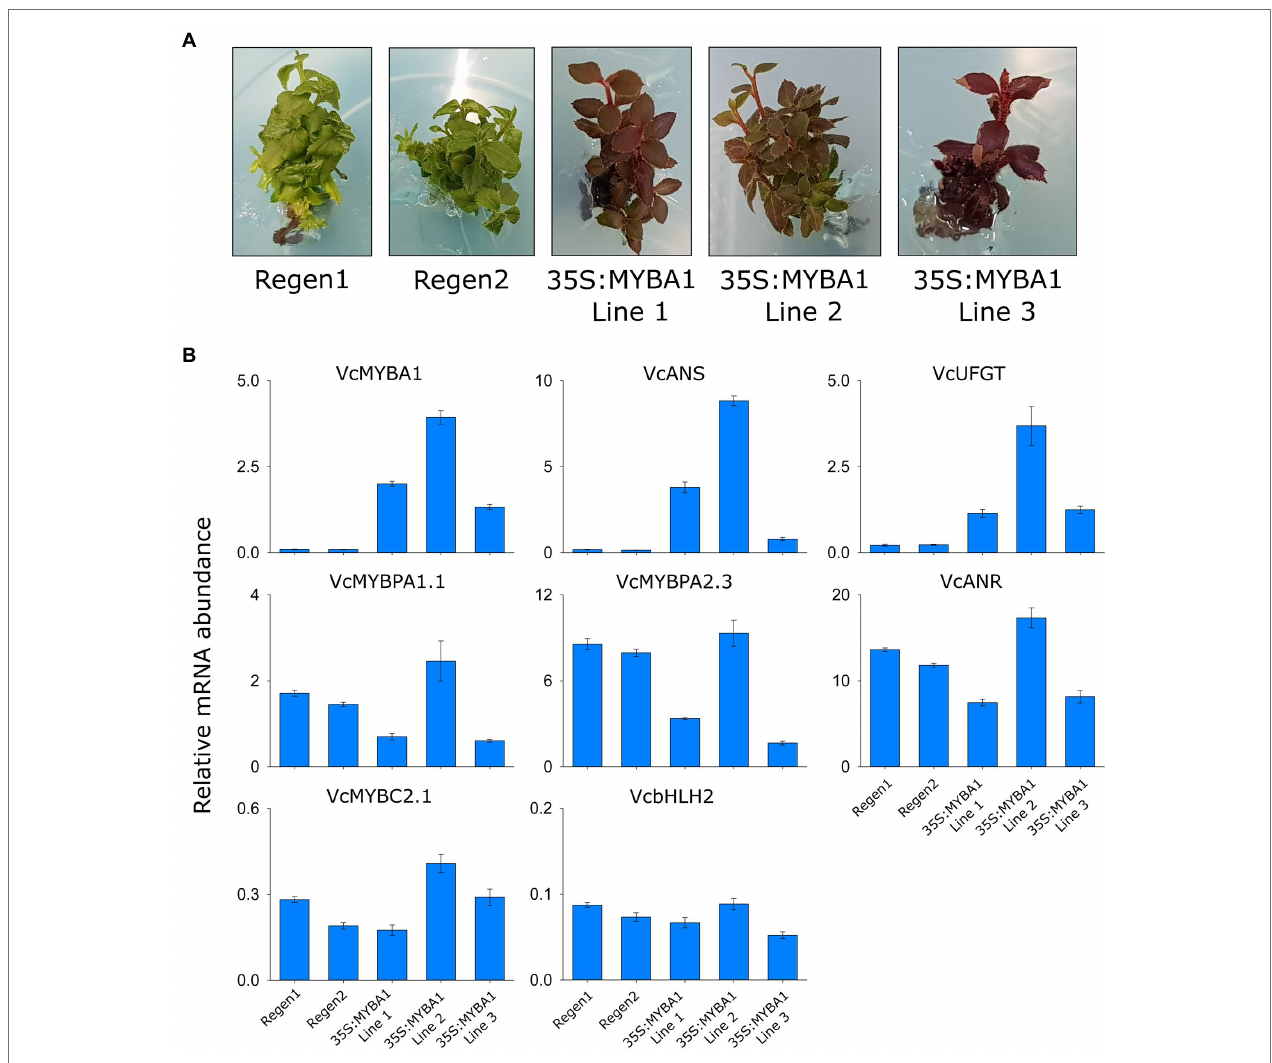
FIGURE 5 | Stable overexpression of VcMYBA1 in blueberry was sufficient to enhance vegetative anthocyanin content. (A) Pigmentation phenotype of two regeneration lines, Regen 1 and 2, and three 35S:VcMYBA1 lines in tissue culture. (B) Expression analysis was performed on the regeneration controls and 35S:VcMYBA1 lines using qRT-PCR. Values represent means ± SEs of three biological replicates. All values are relative to the geometric mean of abundance of GAPDH and Actin reference gene